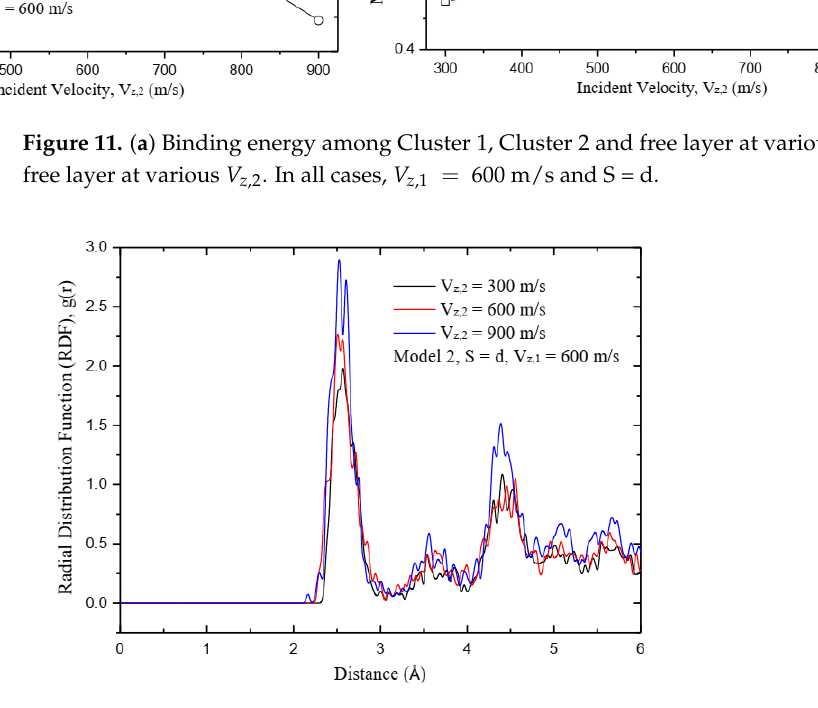
Figure 12. RDFs in Model 2: V 1, z = 600 m/s and various V 2, z